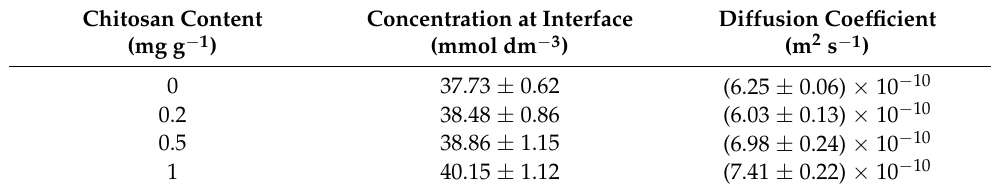
Table 2. Values of concentration of copper(II) ions at interfaces and diffusion coefficients determined for studied